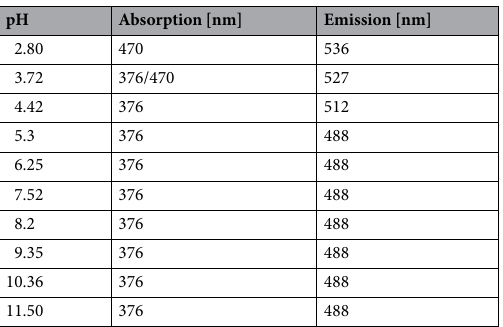
Table 2. Spectroscopic properties of compound BC15 depending on the pH of the solution.